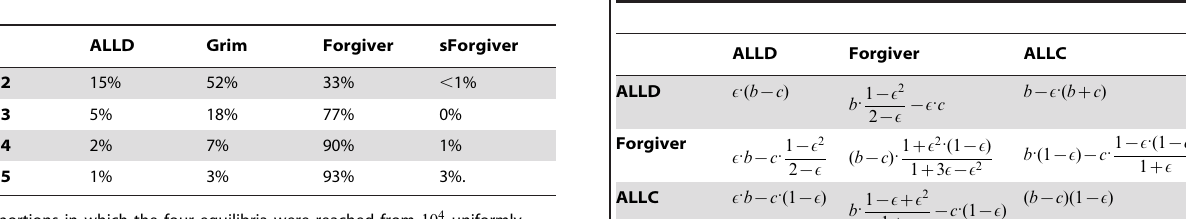
Table 2. Equilibrium frequencies.